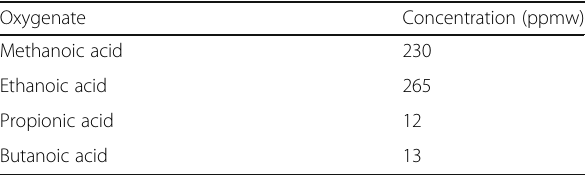
Table 2 HPLC analysis of aqueous phase, Aq1